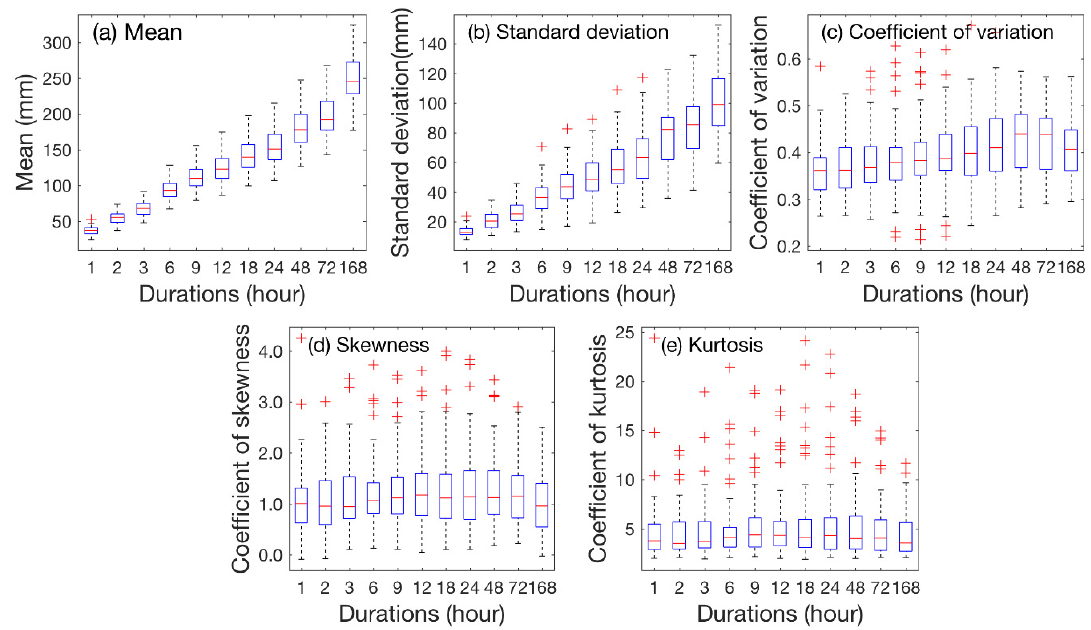
Figure 2. Mean, coefficient of variation, skewness, and kurtosis of annual maximum data for each duration used in this study. Red bars indicate medians of the data points. Top and bottom of the box are data points corresponding to 25th and 75th percentiles, respectively. The red crosses indicate out liars. The outliers are defined as the data points with are above 1.5 ∗ ( q 75 − q 25 ) or below 1.5 ∗ ( q 25 − q 75 ) . q and q are the data points of 25th and 75th percentiles respectively. ( a ) Mean, ( b ) Standard deviation, ( c ) Coefficient of variation, ( d ) Skewness, ( e ) Kurtosis.